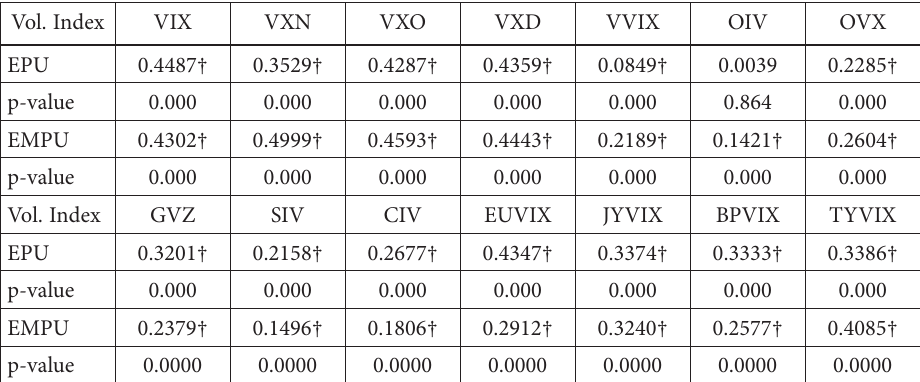
Table 2. Correlation